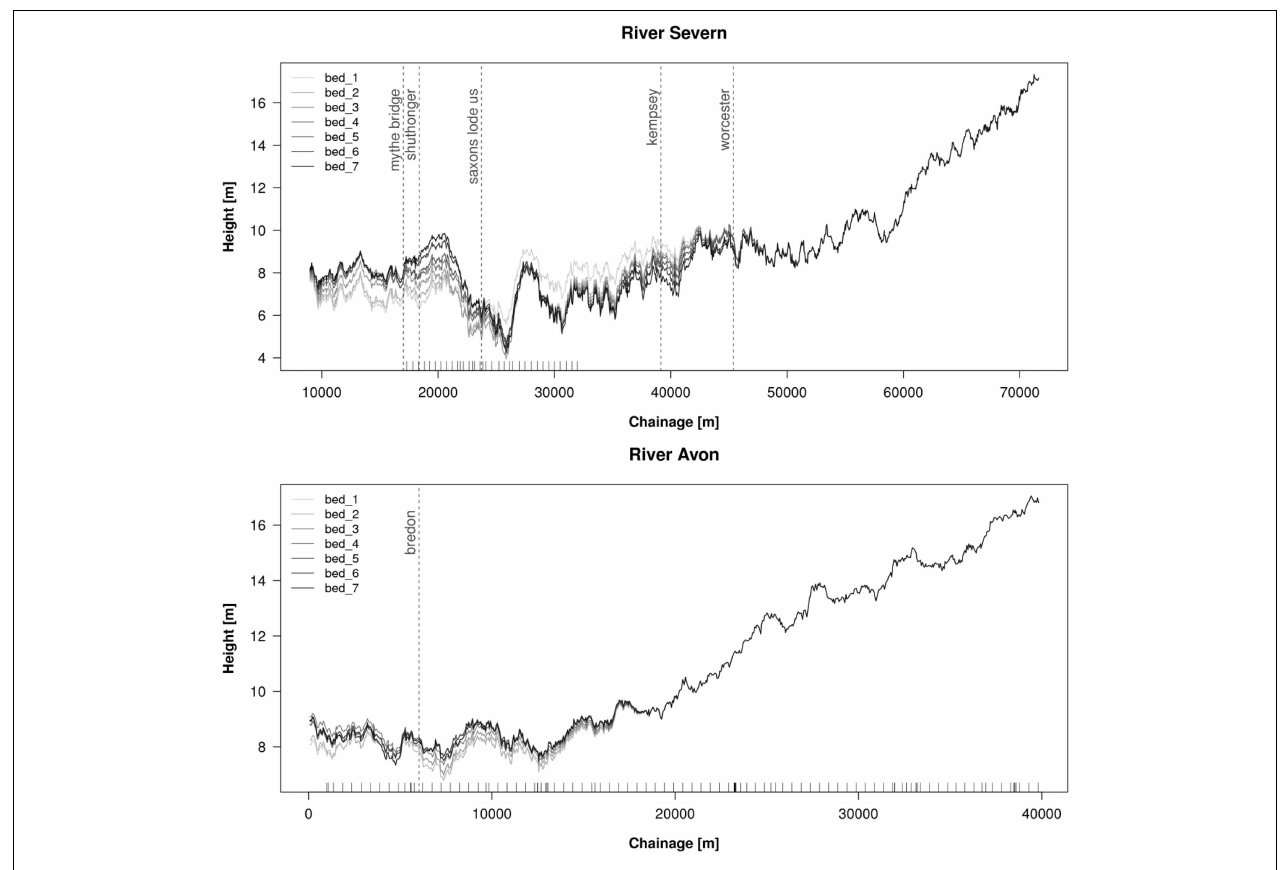
FIGURE 7 | Evolution of the estimate of bathymetry during the seven sequential assimilation steps for the river Severn (top), and the Avon (bottom), for a filter configuration in which bathymetry but not friction was estimated. The ticks at the